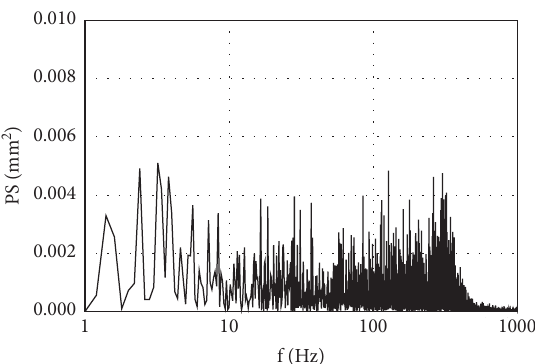
Figure 13: Power spectrum of shock oscillations for roughness at X / C � 0.21 and Ra � 20 μ